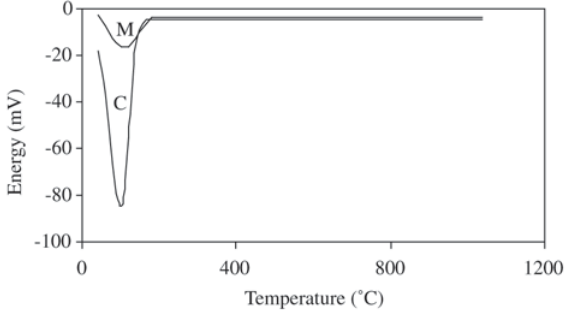
Figure 5. Differential thermal analyses of silica gels obtained via conventional (C) heating and via microwave (M) heating.